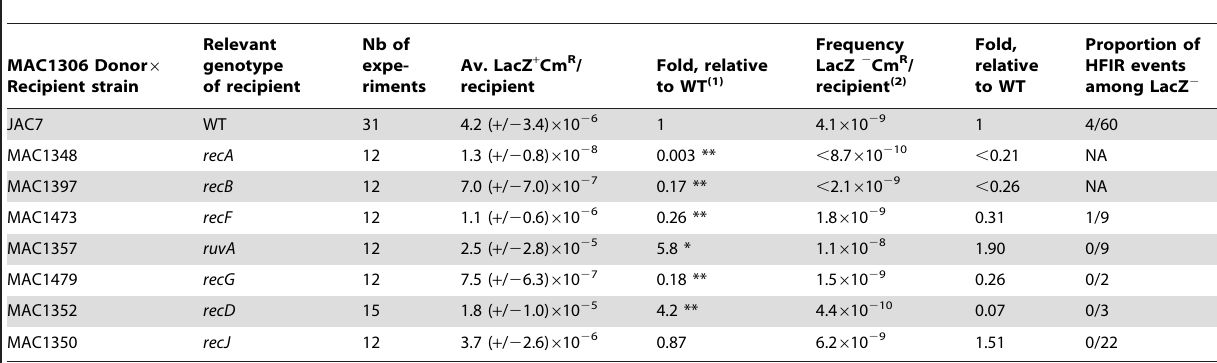
Table 5. Recombination frequencies with linear pJA2 in E. coli mutant